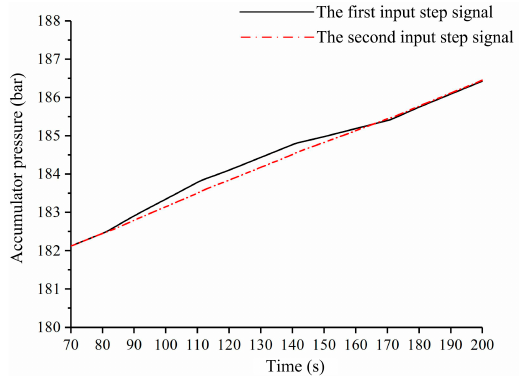
Figure 21. The energy storage pressure curve.